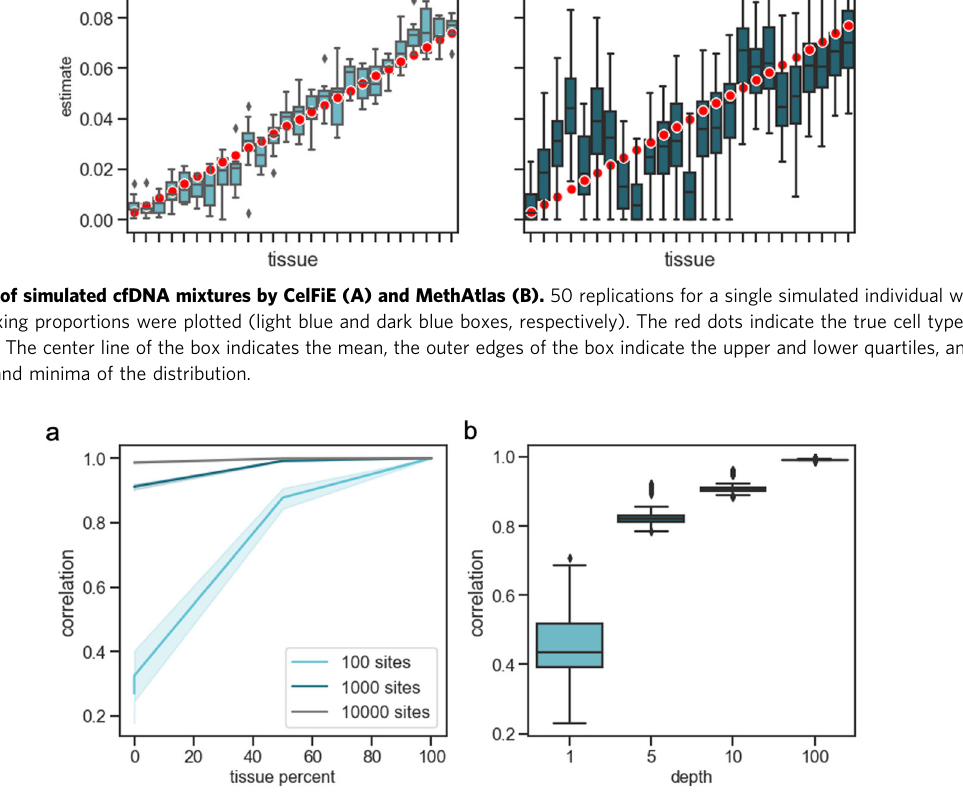
Fig. 2 The performance of CelFiE on simulated mixtures. First, a cell type is fi xed at a proportion between 0% and 100%, and reads are simulated for 100 (light blue line), 1000 (dark blue line), and 10,000 (black line) CpG sites at 10× depth ( a ). The Pearson ’ s correlation between the true and estimated cell- type proportion is plotted. Solid lines indicate the mean and the shading around the line indicates a 95% con fi dence interval. On ( b ) the average Pearson ’ s correlation between the true methylation values for the fi xed tissues and the CelFiE estimated methylation values for 1000 sites simulated with 1×, 5×, 10×, and 100× depths (light blue boxes). The center of the boxplot indicates the mean of the distribution, the edges of the box indicate the upper and lower quartiles, and the edge of the whiskers indicate the maxima and minima of the distribution. Data is shown for 50 independent simulations of one